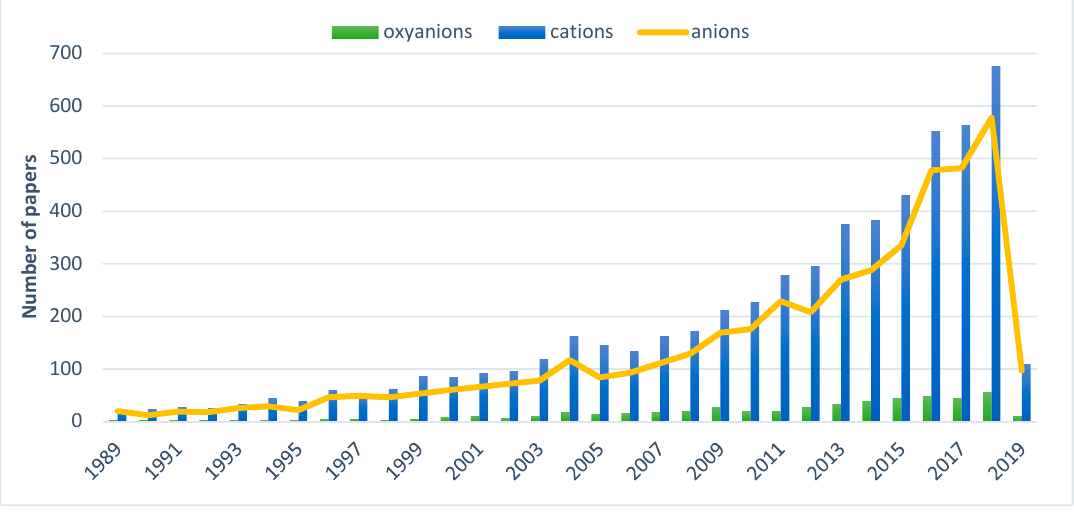
Figure 1. Bar chart of the number of articles per year concerning cations, anions and oxyanions